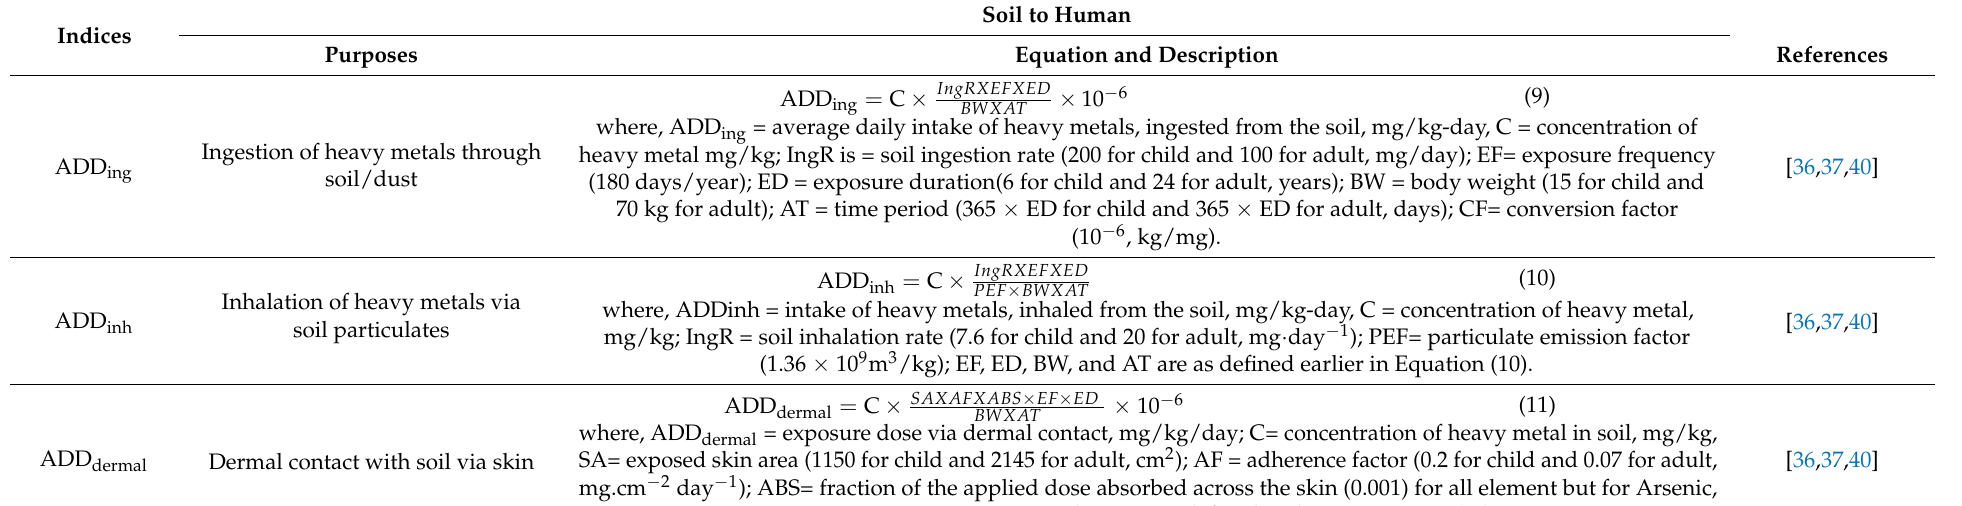
Table 1. Description of the health risk indices utilized to estimate heavy metal impact from soil to